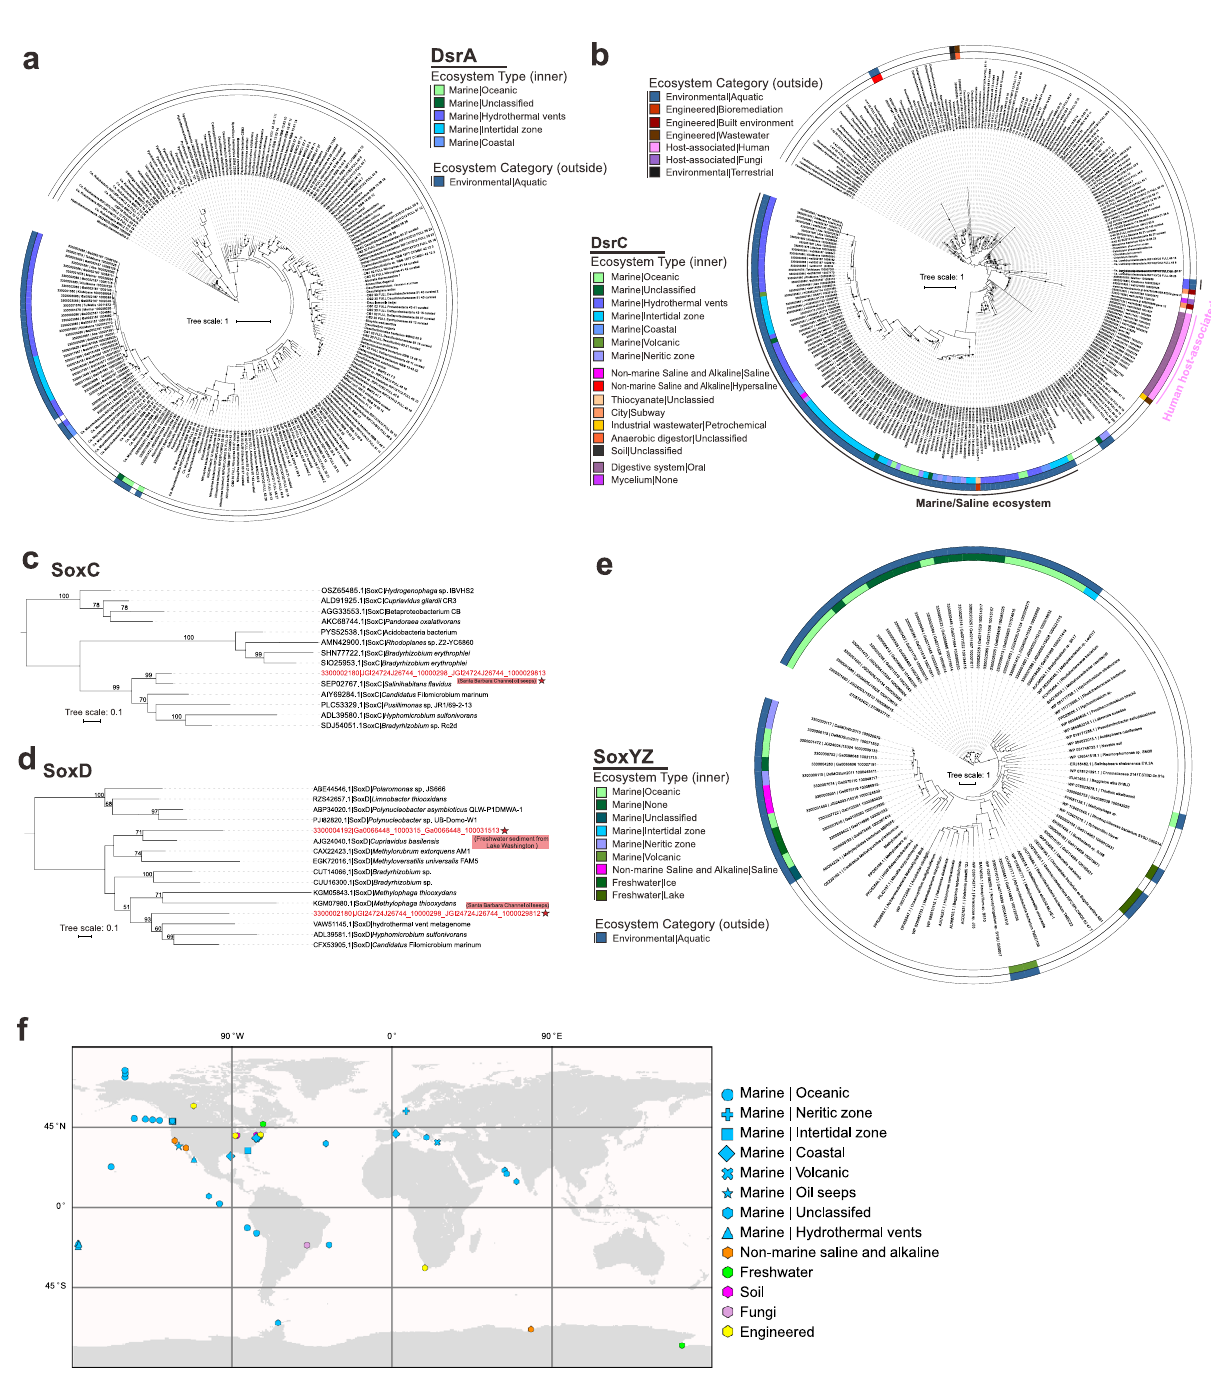
Fig. 3 Phylogenetic tree of AMG proteins and distribution of phage genomes (on a world map). a , b Phylogenetic trees of phage DsrA and DsrC. c , d , e SoxC, SoxD, SoxYZ. Ultrafast bootstrap (UFBoot) support values (>50%) are labeled on the nodes. c , d Phage gene encoded protein sequences are labeled with stars and their environmental origin information is labeled accordingly. The ecosystem type (inner ring) and ecosystem category (outside ring) are provided for phage genomes in the phylogenetic trees in a , b , e ; different colors represent different ecosystem type and ecosystem category in the legends, blank places in each ring are for microbial references. f World map showing distribution of phage genomes that contain the sulfur-related AMGs. Studies on human systems are excluded from the map. Different ecosystem types are represented by different symbols and colors in the different prokaryote-infecting viral families (see Methods). The majority of mVCs were assigned to Myoviridae (132 mVCs; 69%), Siphoviridae (43 mVCs; 22%) and Podoviridae (9 mVCs; 5%). These three families represent dsDNA phages belonging to the order Caudovirales . The remaining seven mVCs were identi fi ed as ambiguous Caudovirales (3 mVCs; 1.5%) and unknown at both the order and family levels (4 mVCs; 2%). However, based on the